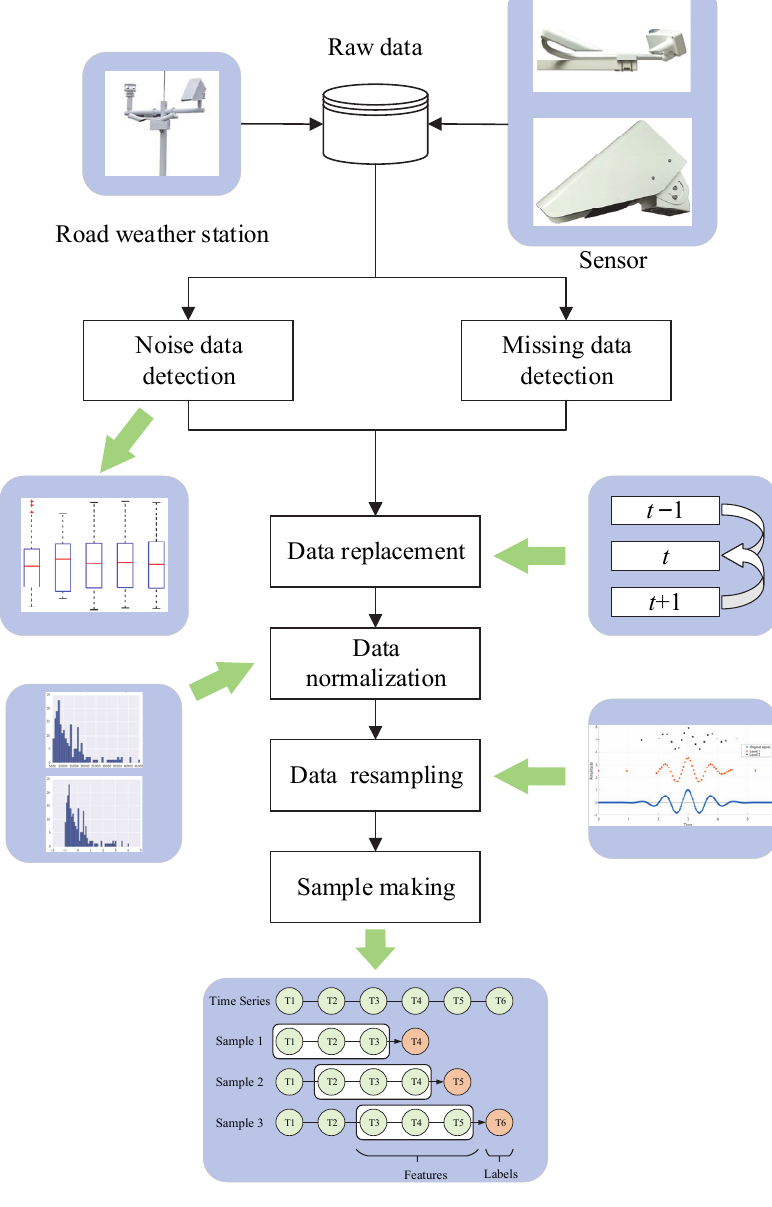
Figure 3. The data processing flow.